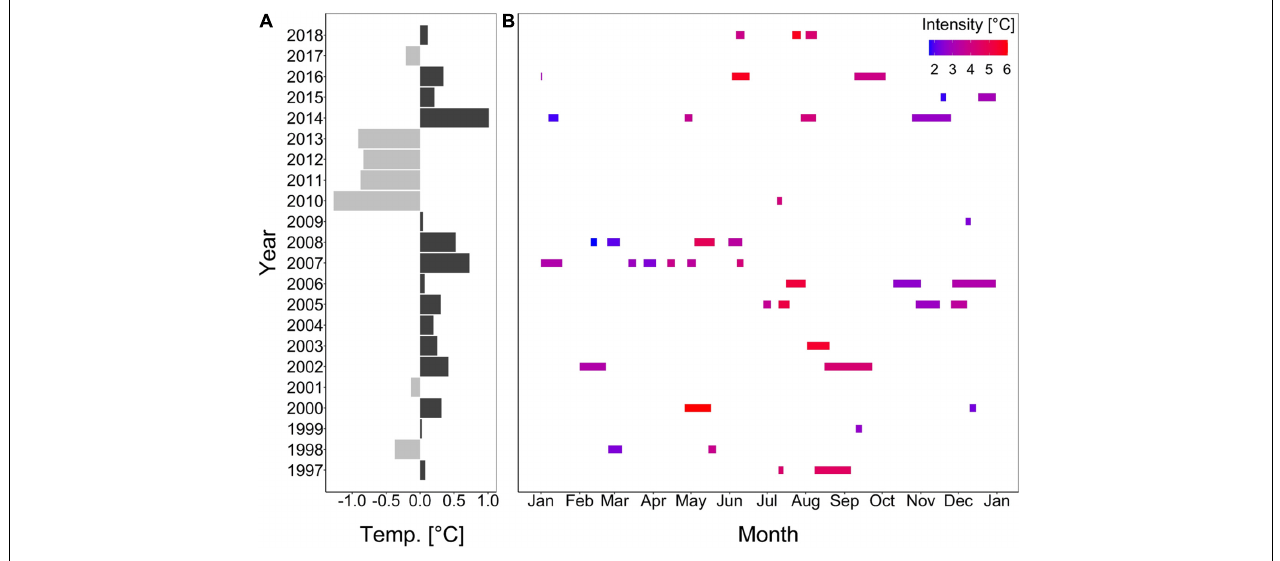
FIGURE 2 | Deviations from annual mean seawater temperature from a 22-year mean ( A ; Wolf et al., 2020) and heatwave durations in different months over the 22-year record (B) . Colors in panel (A) represent cold (light gray) or warm (dark gray) years, and in panel (B) the intensity of the heatwave (i.e., maximum amplitude above the climatological